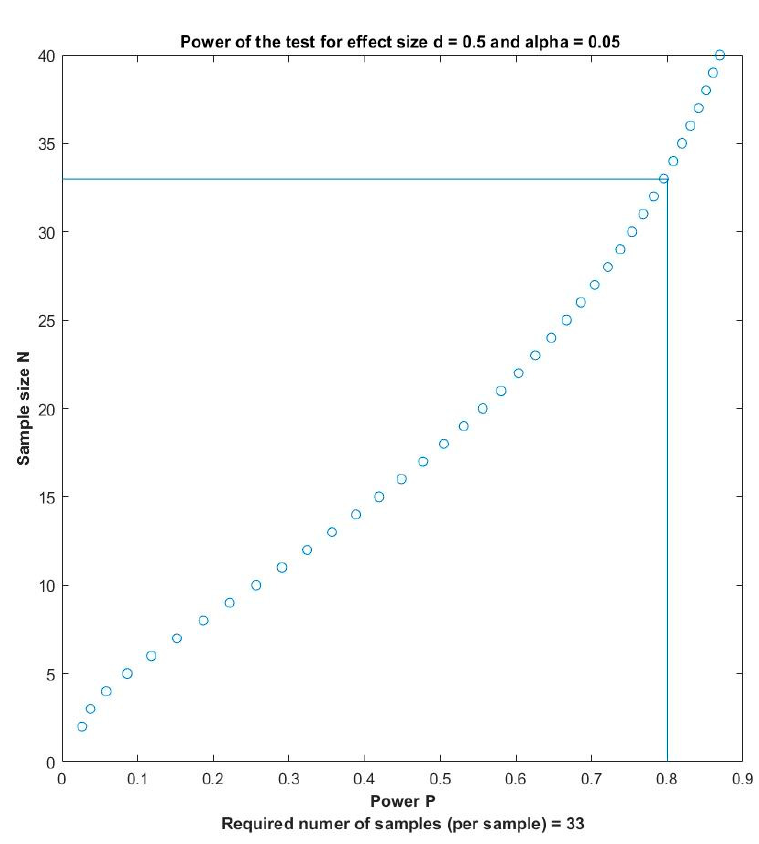
Figure 1. Plot for a calculated number of samples for selected requirements.